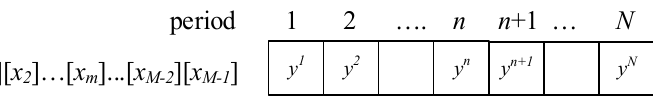
Fig. 5. Solution representation of